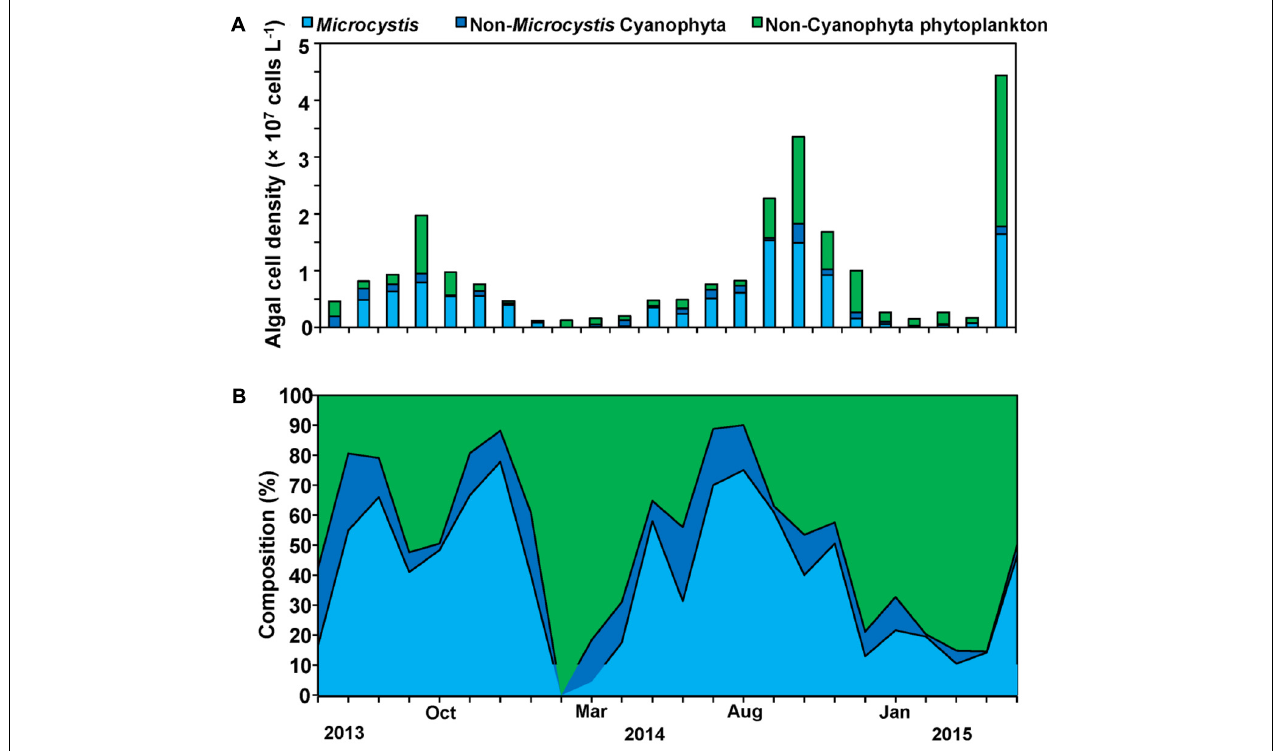
FIGURE 3 | Cell density successions (A) and composition successions (B) of Microcystis , Non- Microcystis Cyanophyta and Non-Cyanophyta phytoplankton cell density.